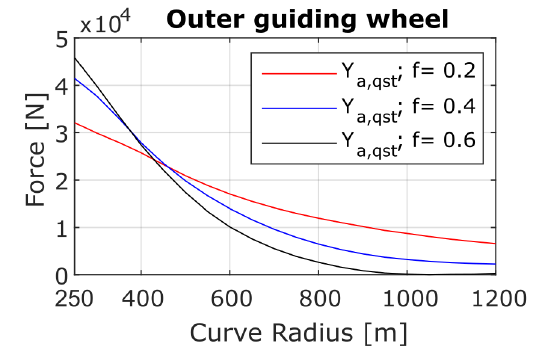
Figure 5. Dependence of the Y radius R in defined range of the friction coefficient values µ .